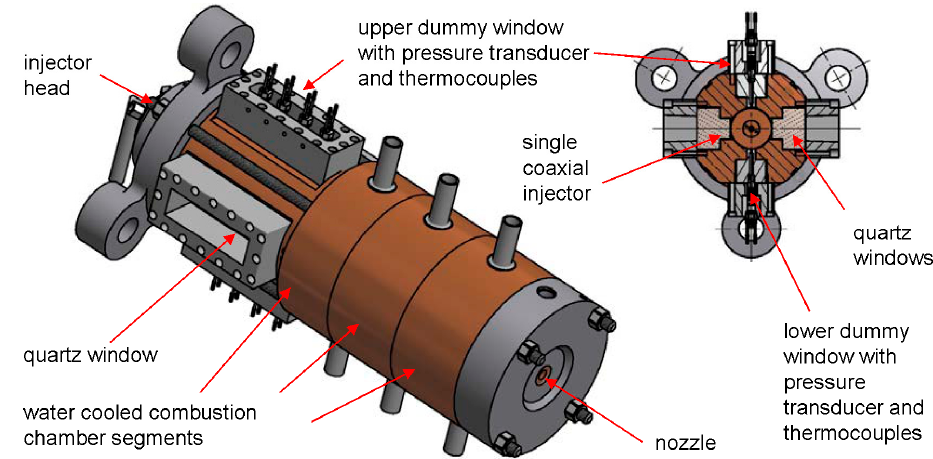
Figure 18. German Aerospace Center (DLR) subscale combustion chamber model “C” [73]. Reproduced with permission from D. I. Suslov and J. S. Hardi; published by the EUCASS association, 2015.